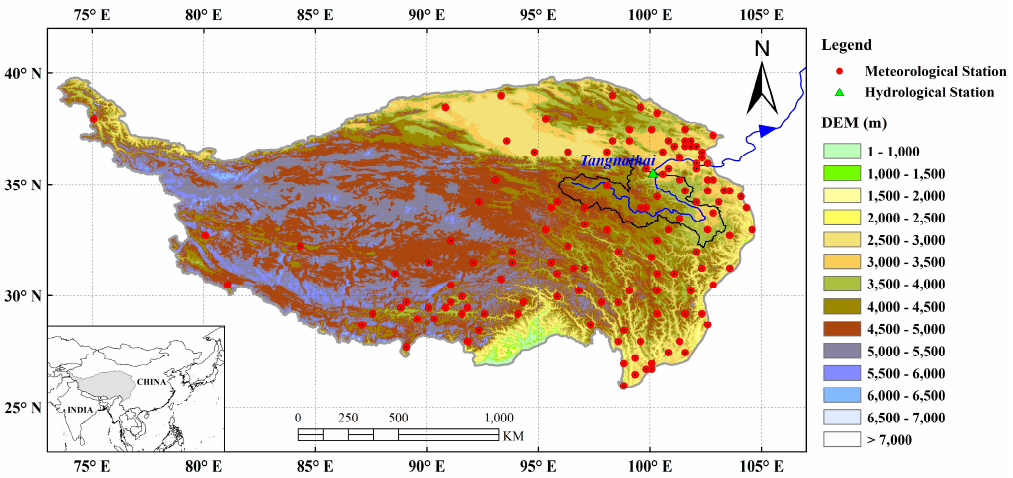
Figure 1. Map and topography of the Tibetan Plateau (TP), meteorological stations, and Tangnaihai hydrological station.